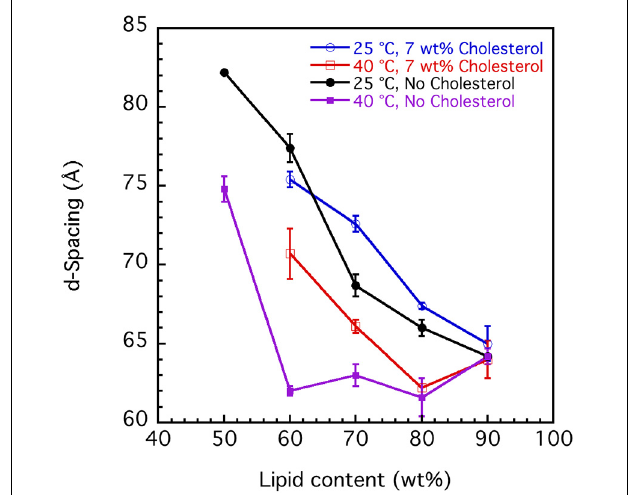
FIGURE 7 | Effect of cholesterol on the interlamellar spacing (d-spacing) obtained from SAXD data as function of porcine brain sphingomyelin content recorded at two different temperatures, 25 ◦ C and 40 ◦ C. The swelling curves for sphingomyelin in 0.9 wt% (154 mM) NaCl and 1 mM CaCl 2 without cholesterol and where 7 wt% of lipid fraction was cholesterol are shown. The obtained values are the mean values calculated from all observed first to fourth order of reflections. For the samples with the largest hydration (50 wt% lipid), the third and fourth order peaks are very broad, and the q value of the peak is, therefore, uncertain. In those cases, we used only the first and second order reflections. The error bars in the graph are the standard deviations of the calculated mean